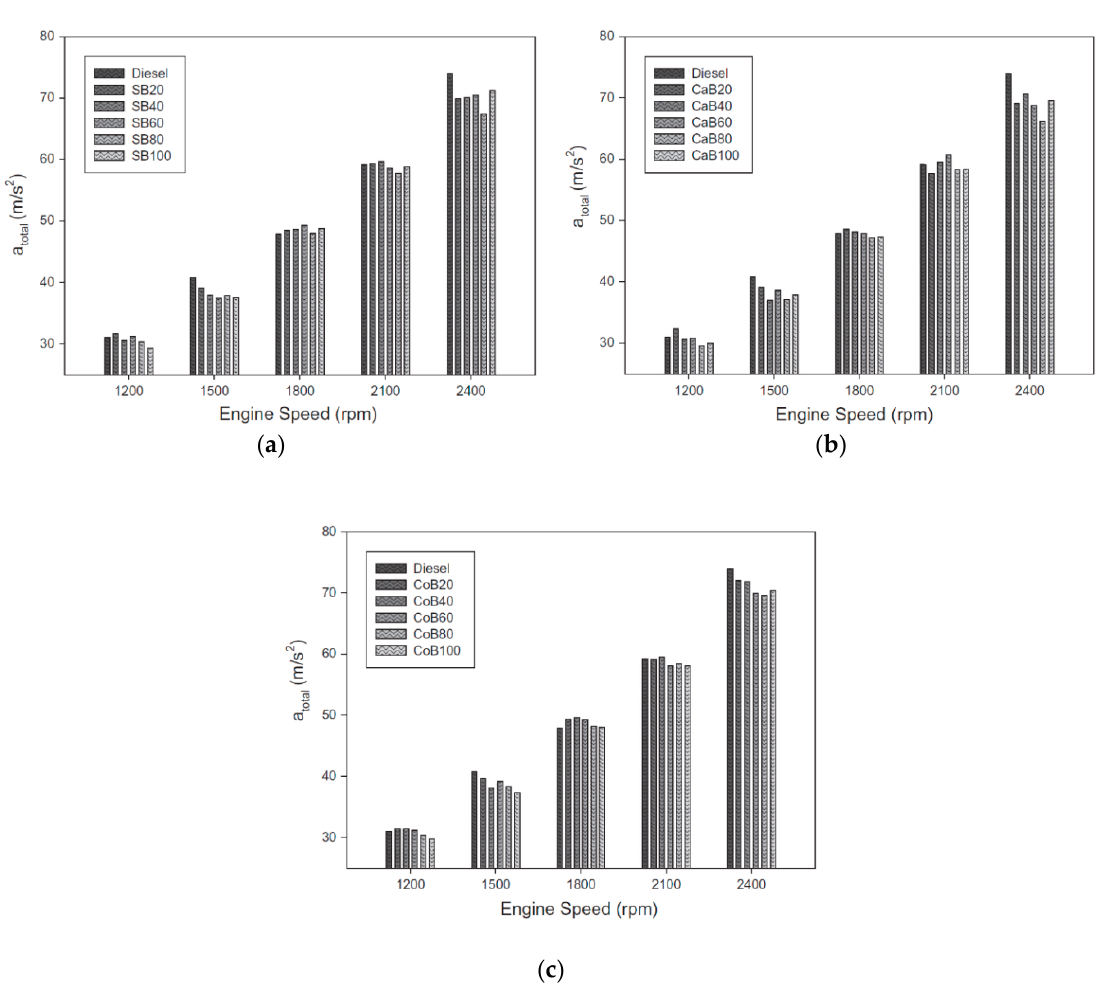
Figure 20. Total engine vibration acceleration (a total ) vs. engine speed when the engine was fueled with low sulfur diesel and ( a ) sunflower oil; ( b ) canola oil; ( c ) corn oil biodiesel fuel blends [71]. Figures are reprinted with permission from publisher.